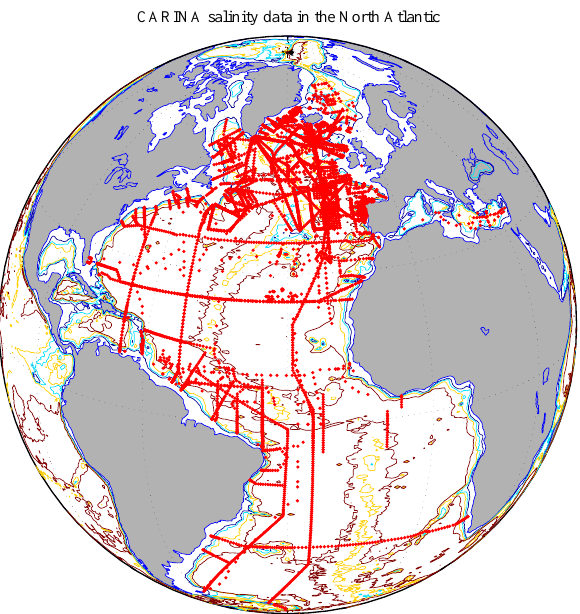
Figure 1. Map with the locations of all stations with salinity mea- surements in the CARINA Atlantic Ocean subset.